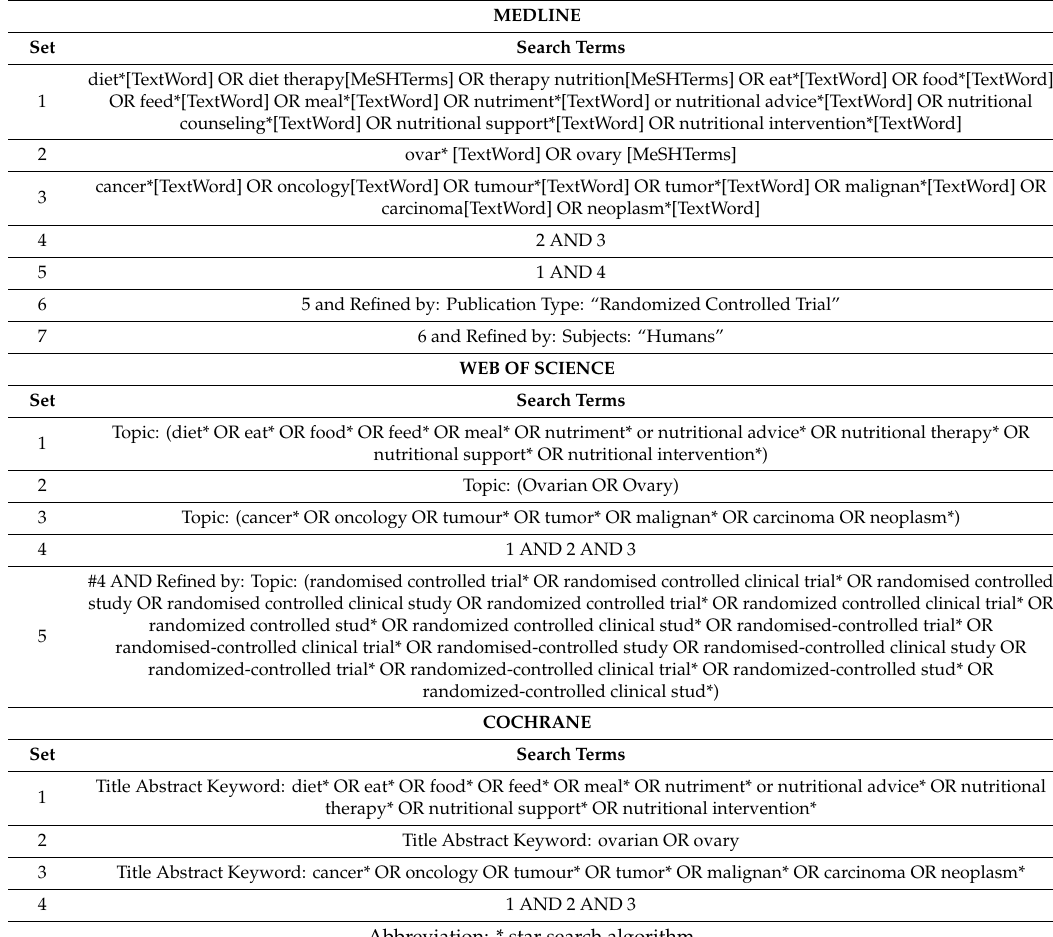
Table 1. Full search strategies for three